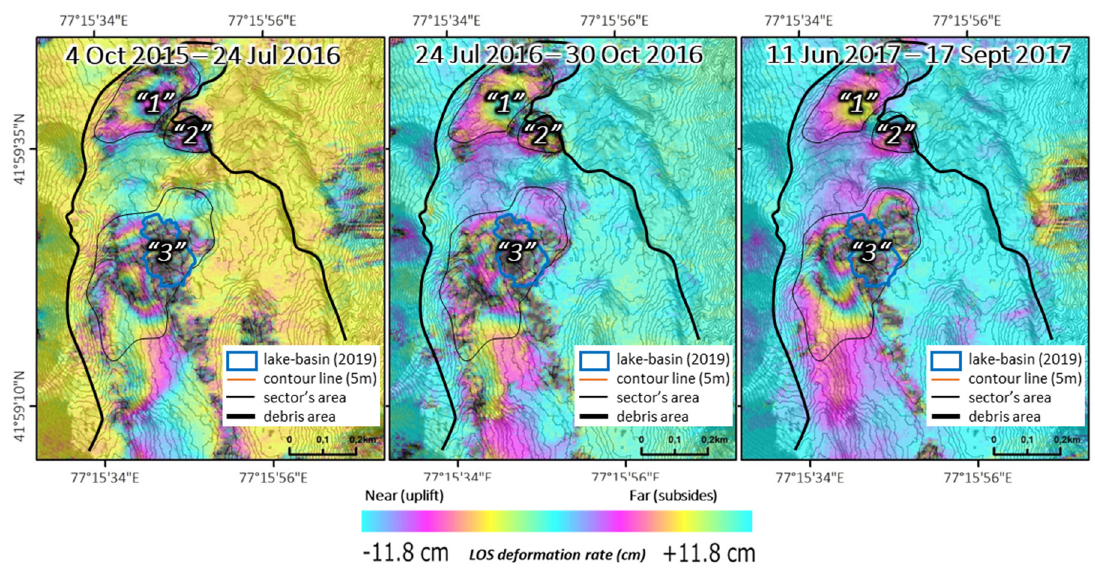
Figure 10. Surface displacement maps, 2015–2017. From differential interferometric SAR (DInSAR) data from ALOS-2/phased array type L-band synthetic aperture radar-2 (PALSAR-2).